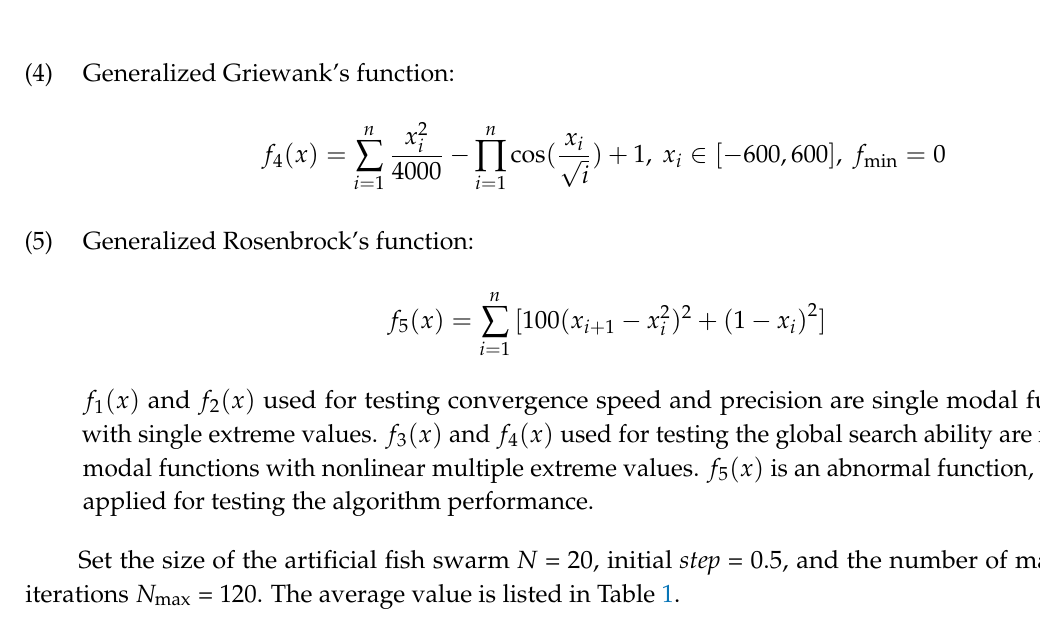
Table 1. Test results.